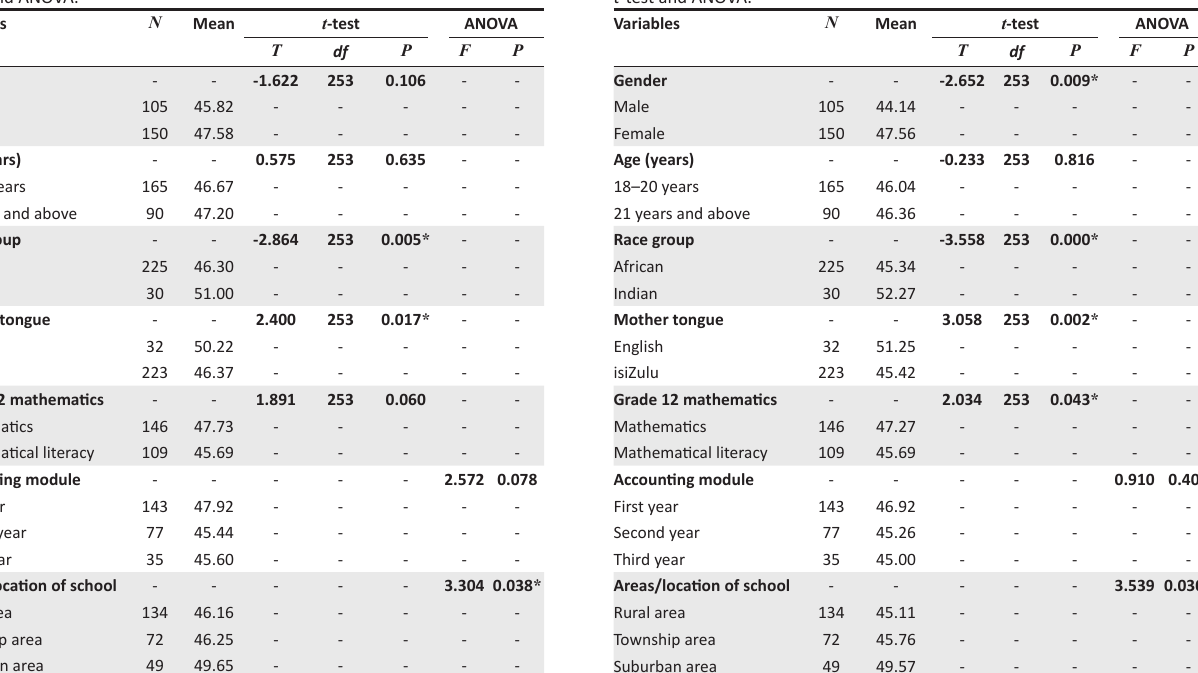
TABLE 7: Comparison: perceived support of father with variables using means, t -test and